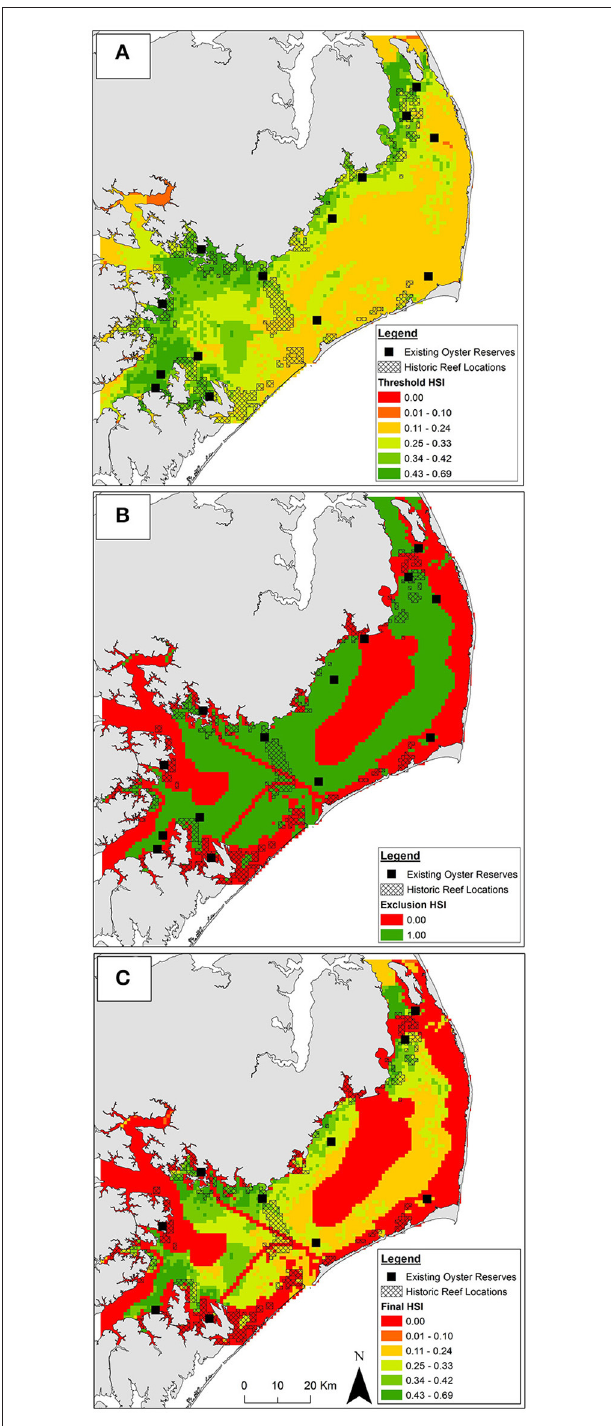
FIGURE 4 | Habitat suitability from (A) aggregated threshold layers, (B) aggregated exclusion layers, and (C) aggregated exclusion and threshold layers combined. In panels (A,C) suitability is represented by a continuous habitat suitability index (HSI). Suitability in panel (B) is binary. Suitability increases from low (red) to high (green) HSI. Existing oyster sanctuaries used for model validation depicted by black squares (not to scale). Location of historic oyster reefs depicted by black